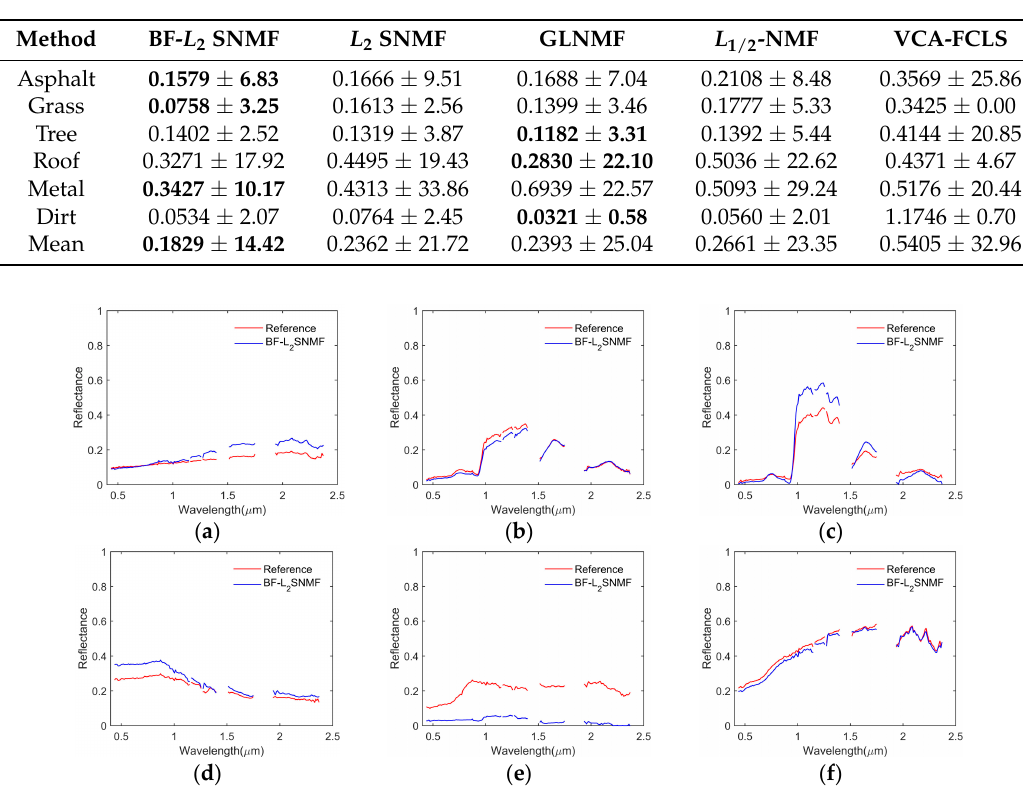
Table 2. SAD values and their standard deviations (10 − 2 ) for different methods with the urban data. The best result in each row is shown in bold.